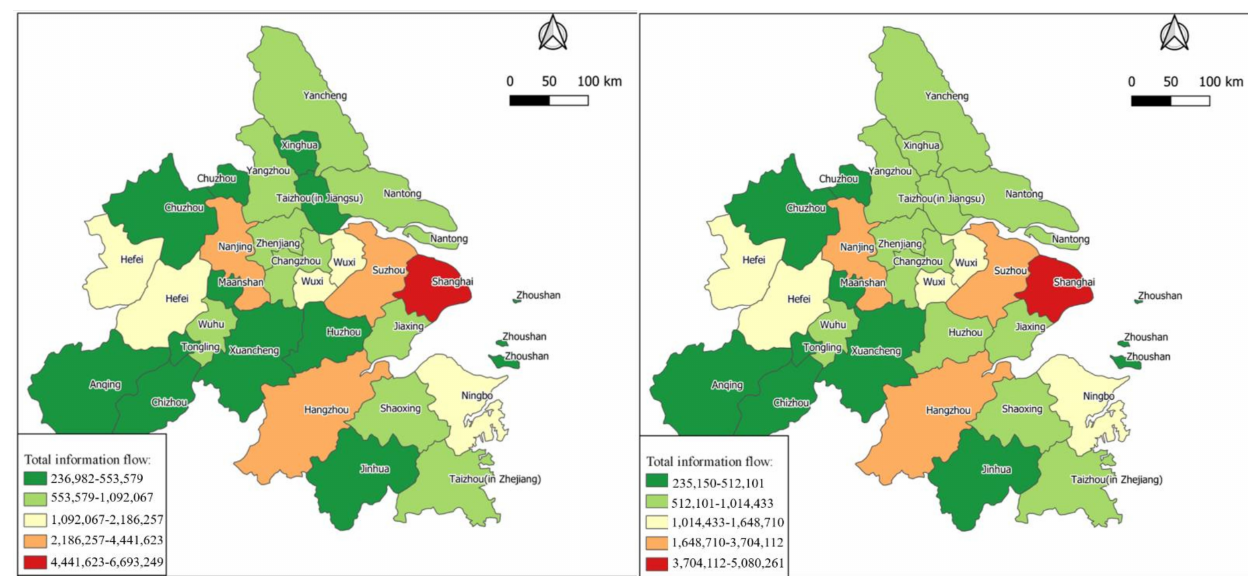
Figure 3. Information flow and proportion of each level: ( a ) 2015; ( b ) 2019.